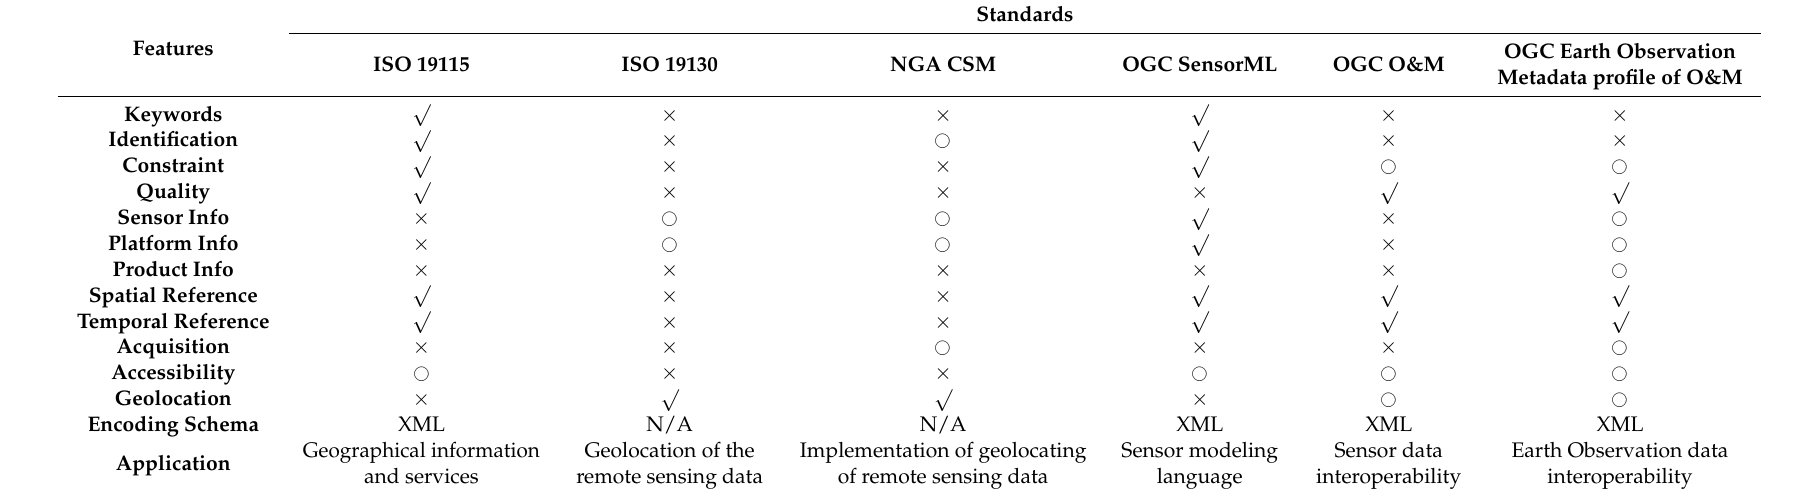
Table 1. Geospatial or observation-related metadata